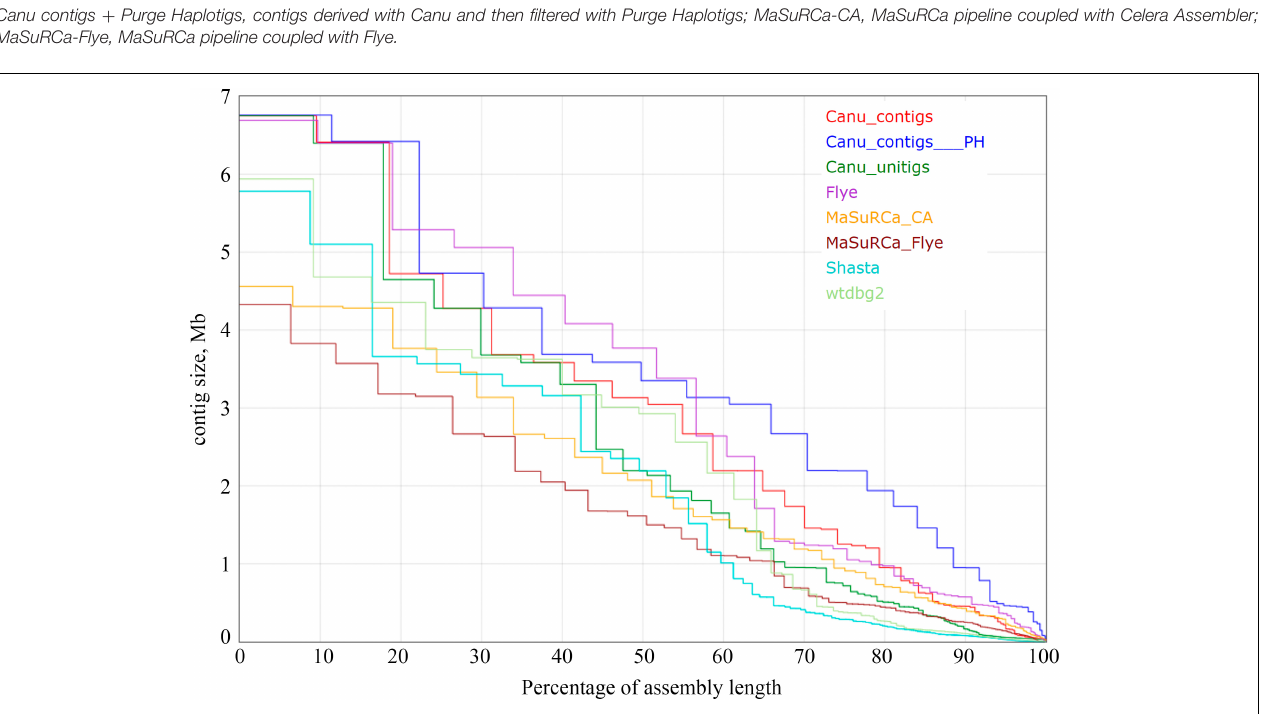
FIGURE 1 | The Nx statistics for Fusarium oxysporum f. sp. lini assemblies. Results for the following assemblers are presented: Canu 1.8 contigs, Canu 1.8 contigs filtered with Purge Haplotigs (Canu_contigs__PH), Canu 1.8 unitigs, Flye 2.6, MaSuRCA 3.3.9 coupled with Celera Assembler (MaSuRCA_CA), MaSuRCA